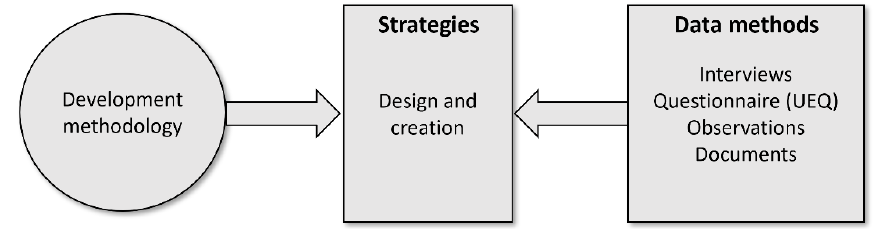
Figure 1. Design and creation approach [31] utilized for this study.